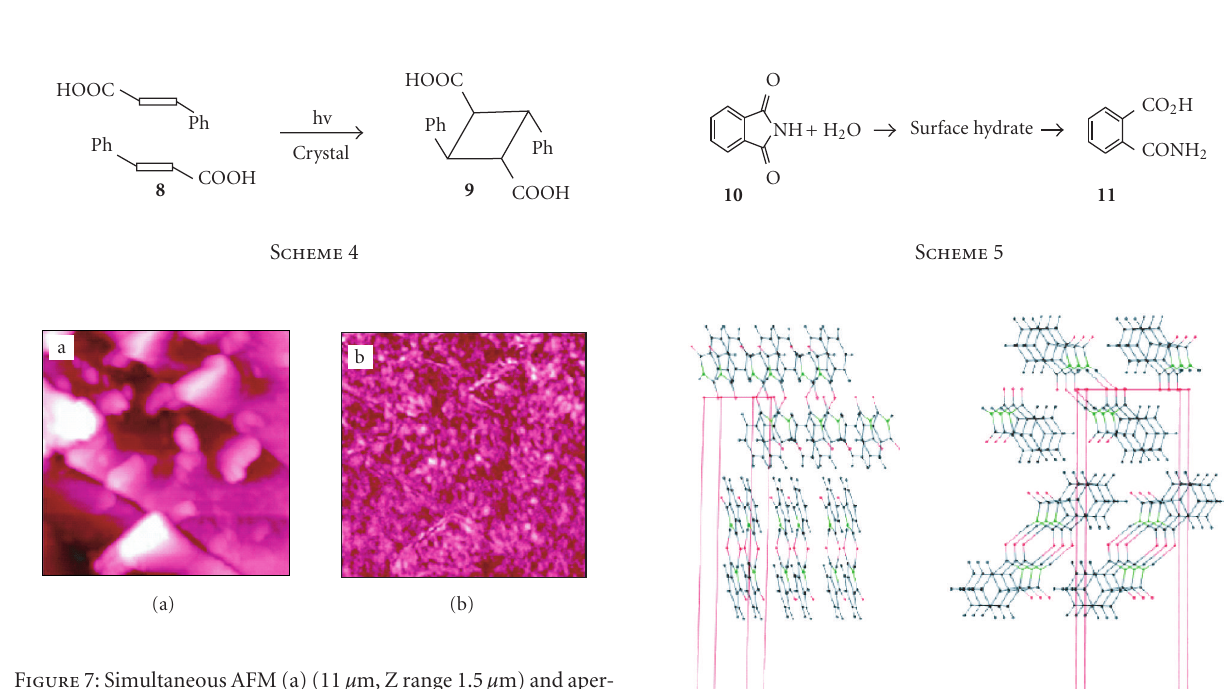
Figure 6: Simultaneous AFM (a) and SNOM (b) of step sites on the (010)-face of sulfanilic acid monohydrate ( 6 ) after short exposure to NO 2 gas (1 : 4 mixture with air injected from a 1cm distance and left for 1min), showing bright chemical contrast in (b) precisely at the slope sites in the various directions where the product ( 7 ) resides.